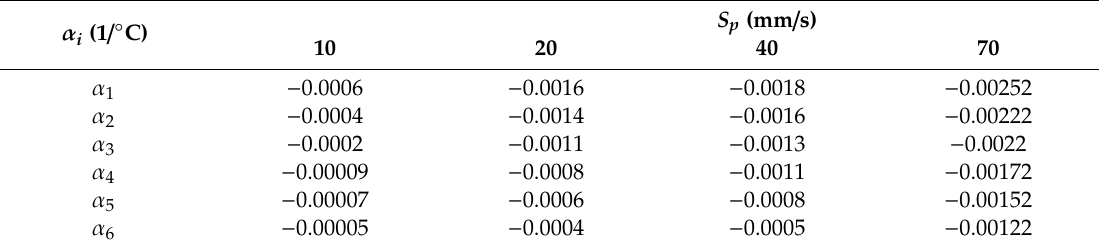
Table 2. The thermal expansion coefficient of each layer for different printing speeds.